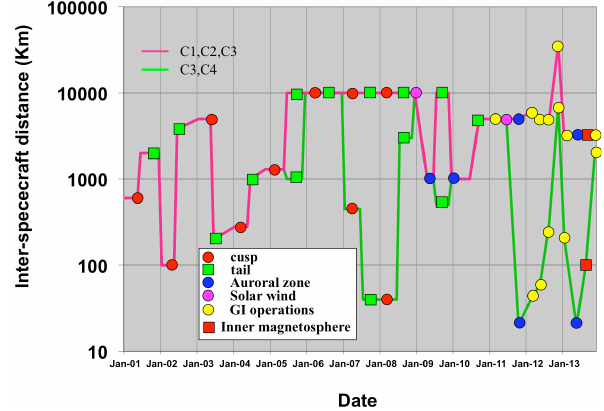
Fig. 1. Cluster constellation from the beginning of the mission up Figure 1. Cluster constellation from the beginning of mission up to now. The distance 3 to now. The distance between the spacecraft is given as a function between the spacecraft is given as a function of time: C1,C2,C3 separation distance in 4 of time: C1, C2, C3 separation distance in magenta and C3, C4 in magenta and C3,C4 in green. The distance is given at one point along the orbit defined by the 5 green. The distance is given at one point along the orbit defined by symbol and colour in the legend. 6 the symbol and colour in the